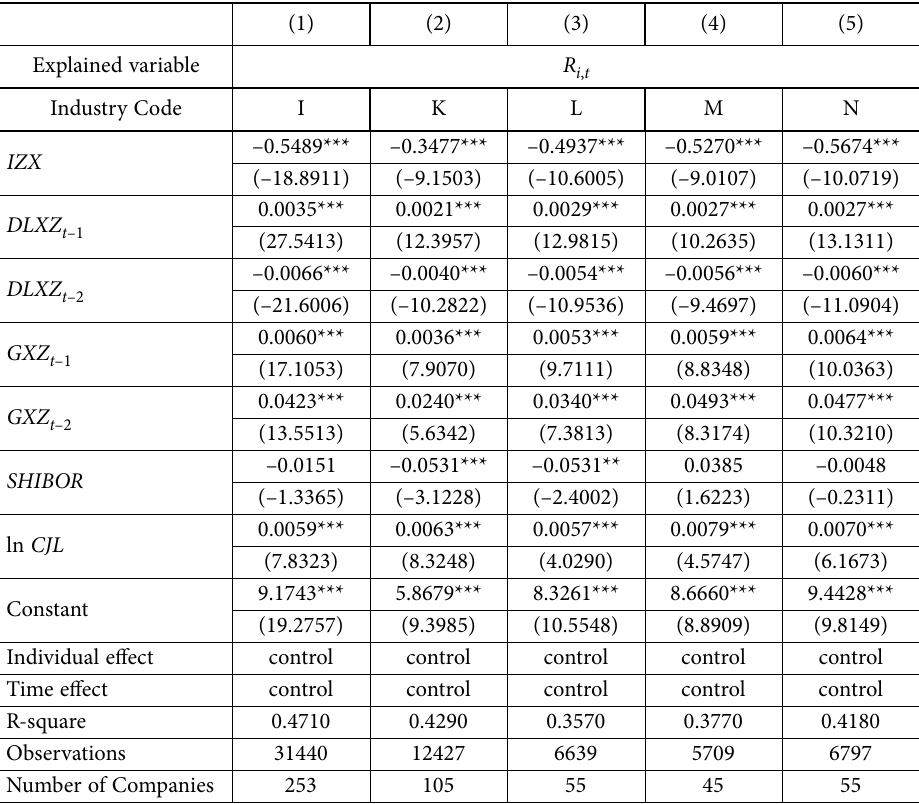
Table 6. Impact of infodemic on stock market